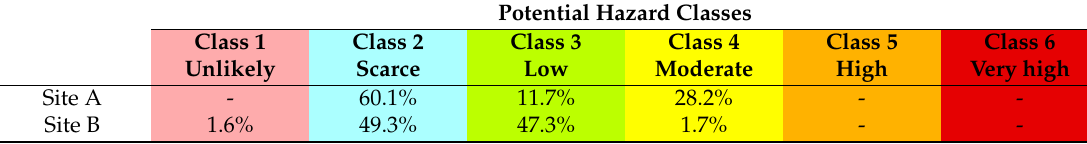
Figure 6. ( a ) Agricultural Nitrate Hazard Index map in the sector comprised between 80 and 20 m a.s.l.; in legend classification of ANHI with the related scores assigned to each class; ( b ) percentage value of potential hazard class related to CUAS class. Table 6. Potential hazard ranking for the study